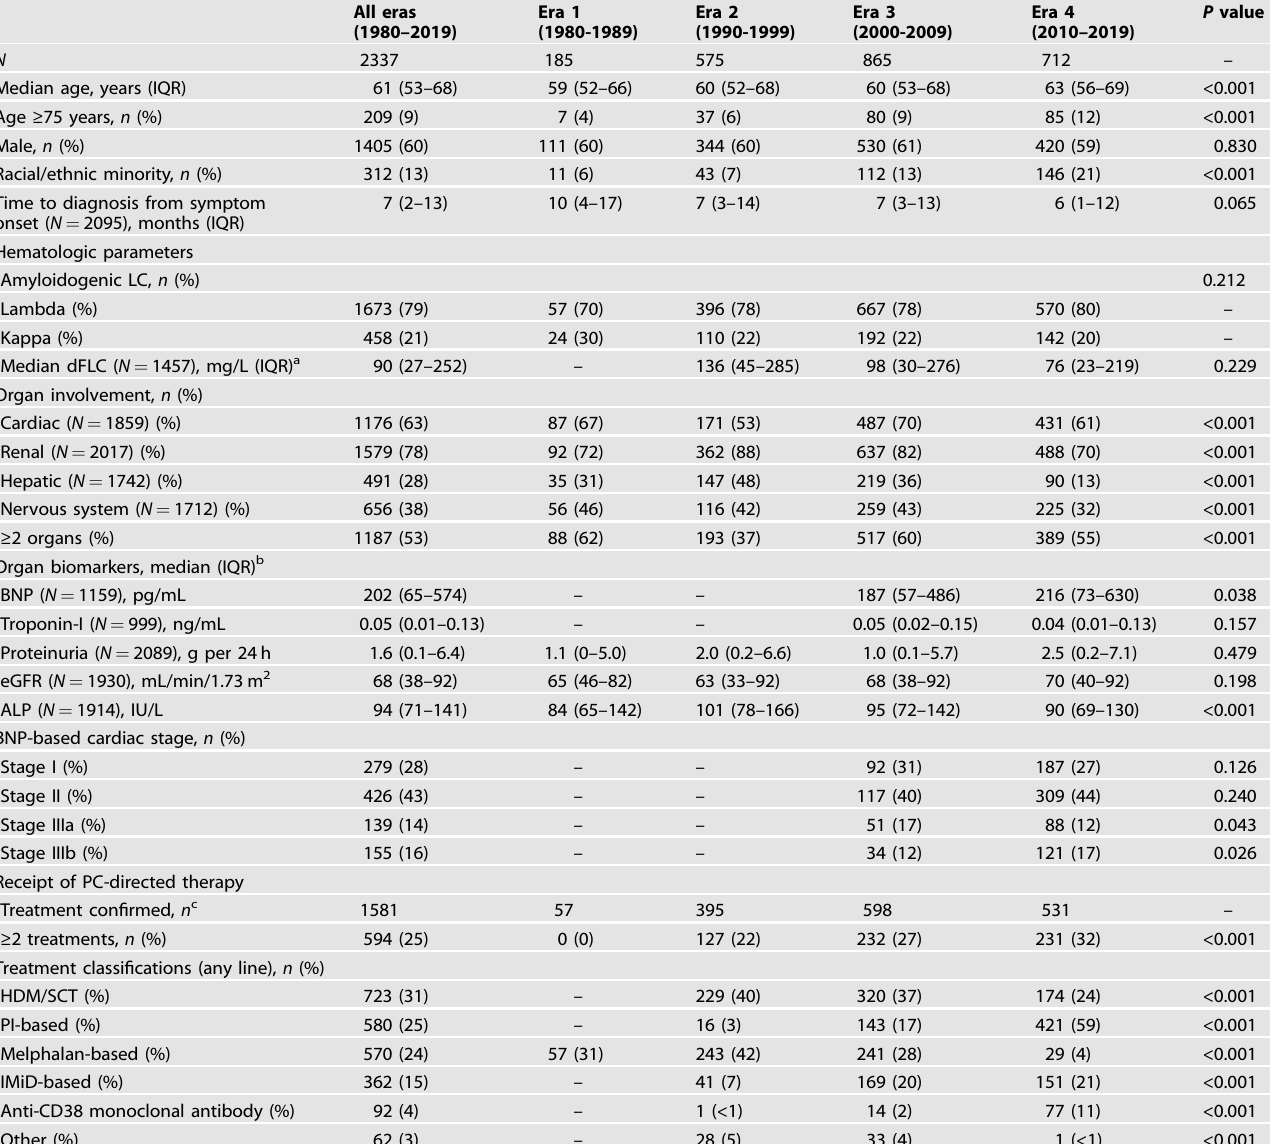
Table 1. Patient characteristics and treatments by era of